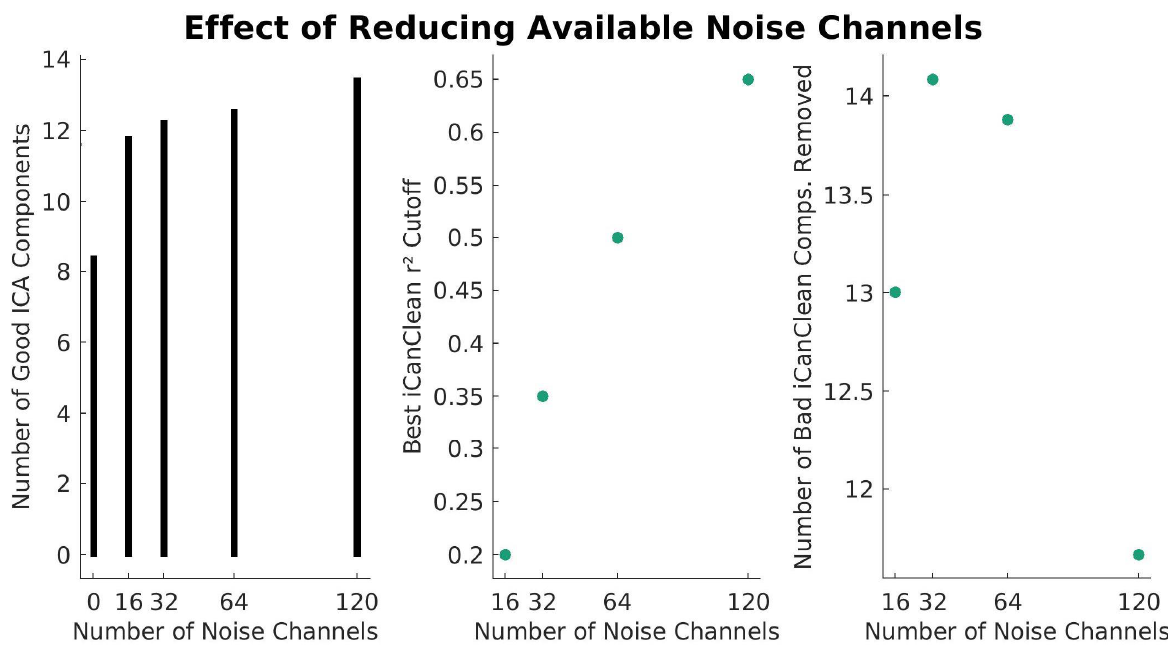
Figure 5. Results from iCanClean parameter sweep for 4 s window with reduced available noise channels. Left : the number of high-quality components is plotted against the number of noise channels used. Middle : the corresponding optimal r 2 threshold (cleaning aggressiveness) is shown for each number of noise channels. Right : the number of bad iCanClean components removed as the number of noise recordings changes. Generally, as fewer noise channels are available, the r 2 cutoff should be lowered (made more aggressive) to compensate, increasing the number of iCanClean components removed. Note that for 0 noise channels, iCanClean is not used, so there is no corresponding r 2 cutoff.